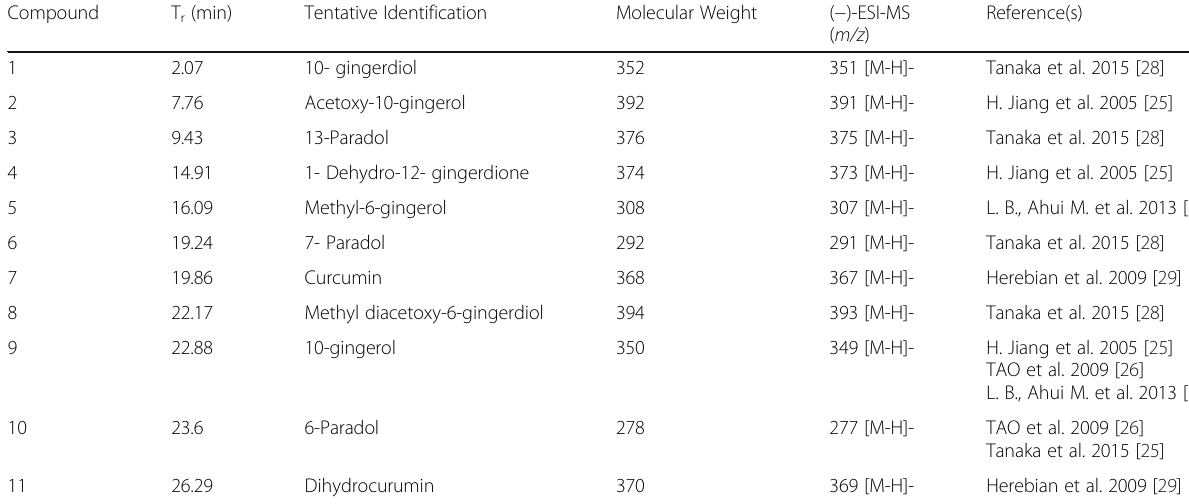
Table 1 Chromatographic, mass spectral characteristics and tentative identification of compounds in the herbal formula by